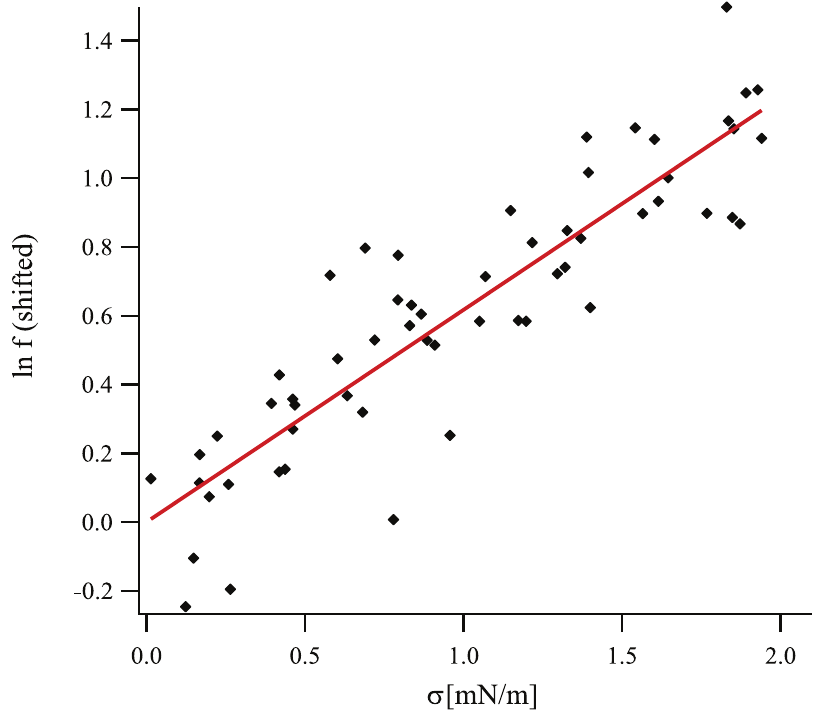
Figure 9. Formation rate f of gramicidin channels as a function of the applied tension s , analyzed with a linear model, for s v 2mN = m . Diamonds: experimental data retrieved from Fig. 6b of Ref. [18], after subtraction of the baselines C k Fig. 7 since the fitting model is here linear instead of quadratic). Line: best linear fit, yielding C 1 ~ (0 : 62 + 0 : 05)(mN = m) { 1 ; correlation coefficient: r ~ 0 : 894 .